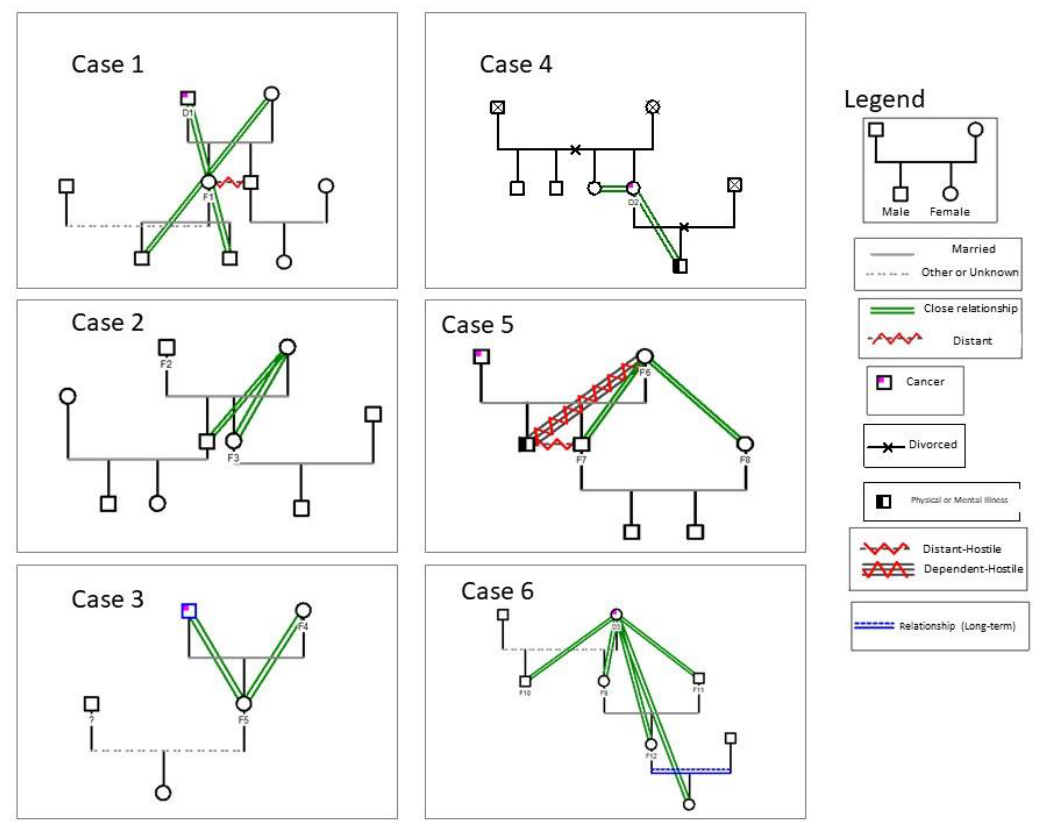
Figure 2. The family genogram of cases included in this